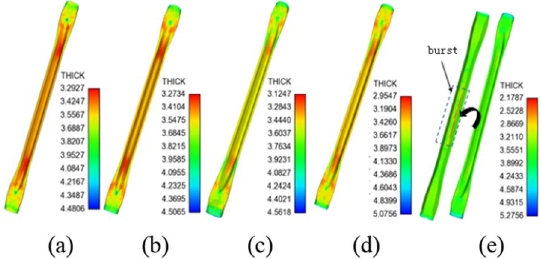
Figure 43 Cloud diagrams of the distribution of the wall thicknesses of torsion beams: ( a ) μ ( e ) μ 0.2 =